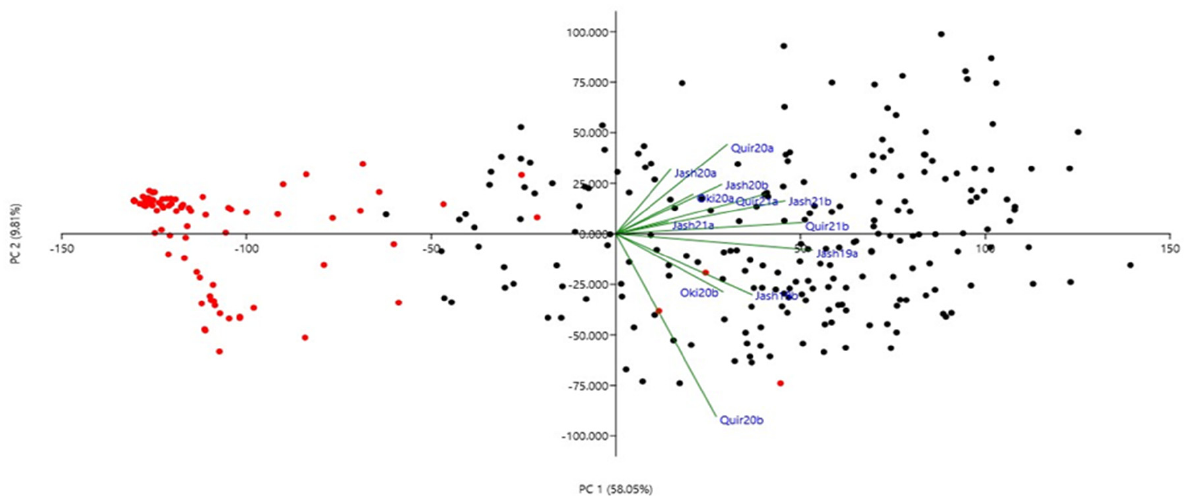
Figure 2. Principal component analysis (PCA) of 298 Indian bread wheat genotypes using wheat blast index across 12 experiments. Red and black symbols denote 2NS and non-2NS genotypes, respectively. Refer to Supplementary Figure S1 for decoding genotype labels.